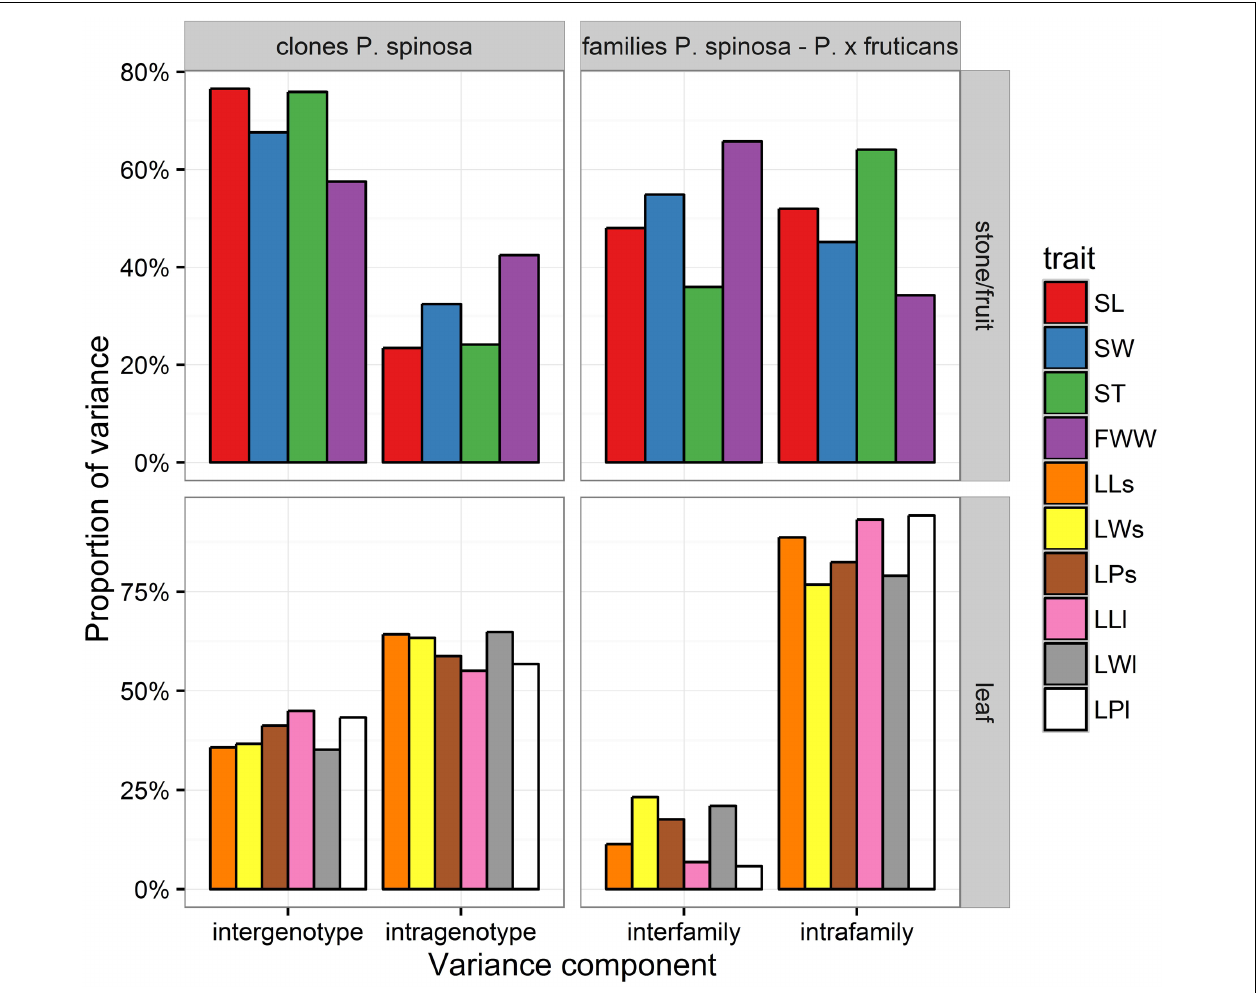
FIGURE 4 | Partitioning of variance for the individual morphological traits in the clone and family plantations. Abbreviations of traits are in Table 2